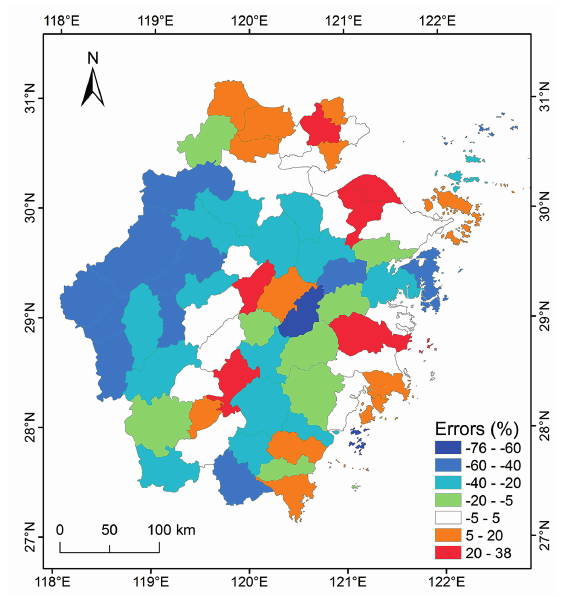
Figure 6. Distribution of non-agricultural GDP modeling error for Zhejiang